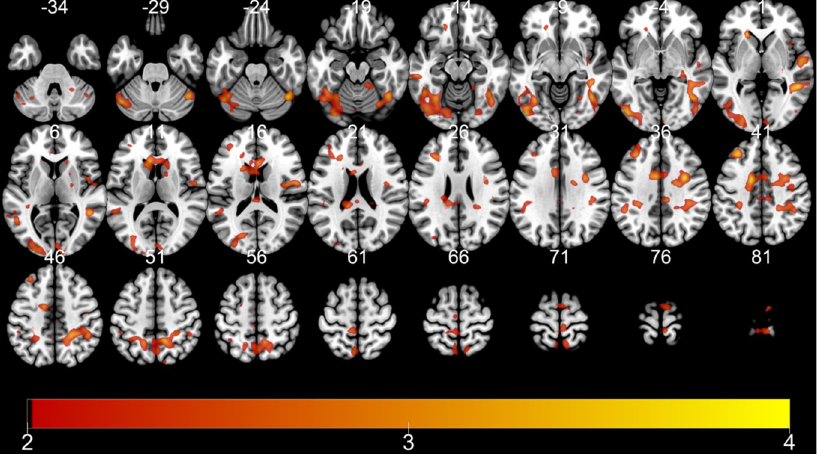
Fig 4. fMRI results (encoding). IE: SME proportionate to TD when retrieved recently. Color bar indicates t-statistics.